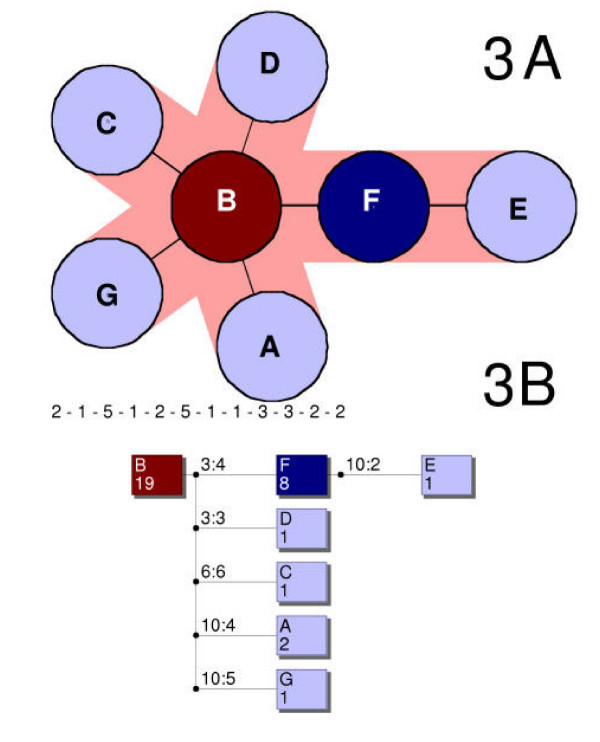
Minimum spanning tree built using the Bionumerics sofware on ST41-Mirutyped DNAs (Version 3.5, Applied Maths, Sint-Marteen-Latem, Belgium). 3A : tree panel window. 3B: complex panel window showing the MIRU value of the presumed origin of the tree. Genotypes are arbitrarily designated by letters. B : 215125113322 is suggested as the original genotype. For each designation, the number of cases is indicated (ex: 22 cases for genotype B). The number on the branch indicates the change required to go from one allele to another : exemple: a change on the 3rd MIRU on genotype B from an allelic value = 5 to a value = 4 provides genotype F.